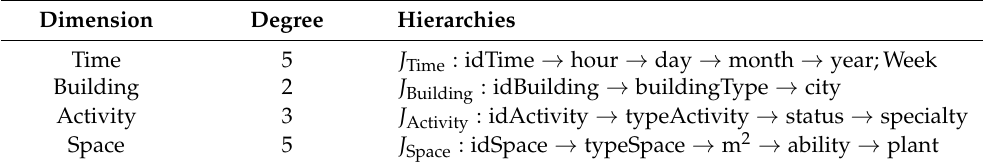
Figure 9. Environment multidimensional variable. Table 3. Dimensions and